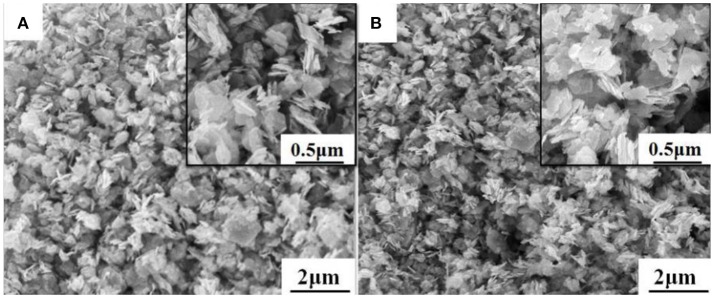
SEM images of (A) pure WO3 nanosheets and (B) 1wt%Rh-WO3 nanosheets.